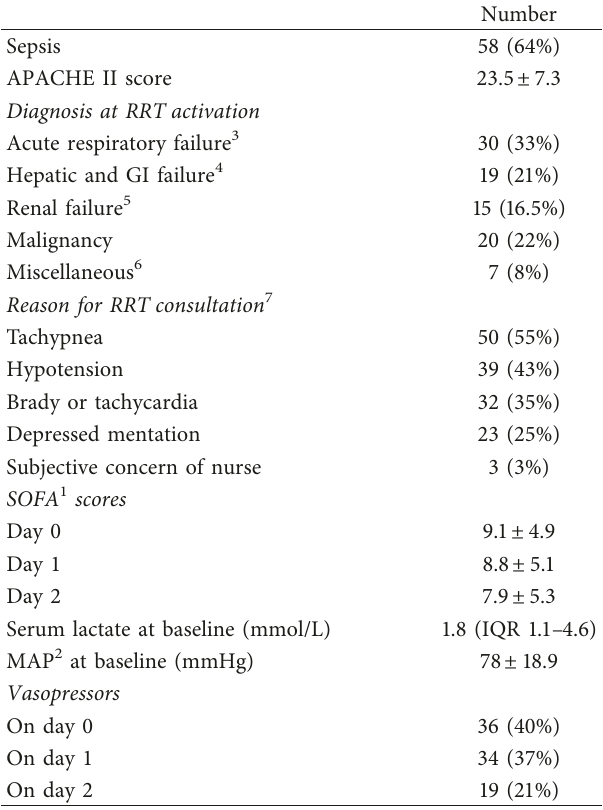
Table 1: Baseline patient characteristics.